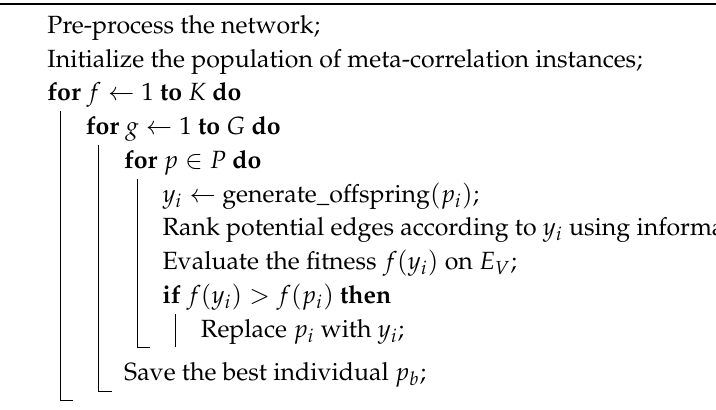
Algorithm 1: Framework structure for Differential Evolution